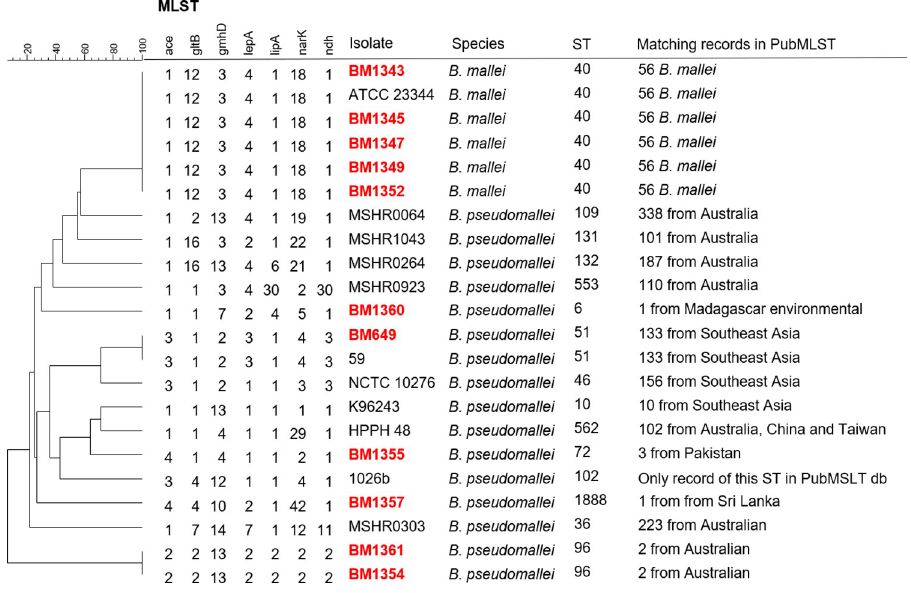
Fig 1. MLST analysis of Burkholderia isolates included in this study (red) and 11 additional records retrieved from the PubMLST db based on genetic variation in seven alleles. Sequence types are compared using categorical clustering (values) and clustered with UPGMA using default settings in